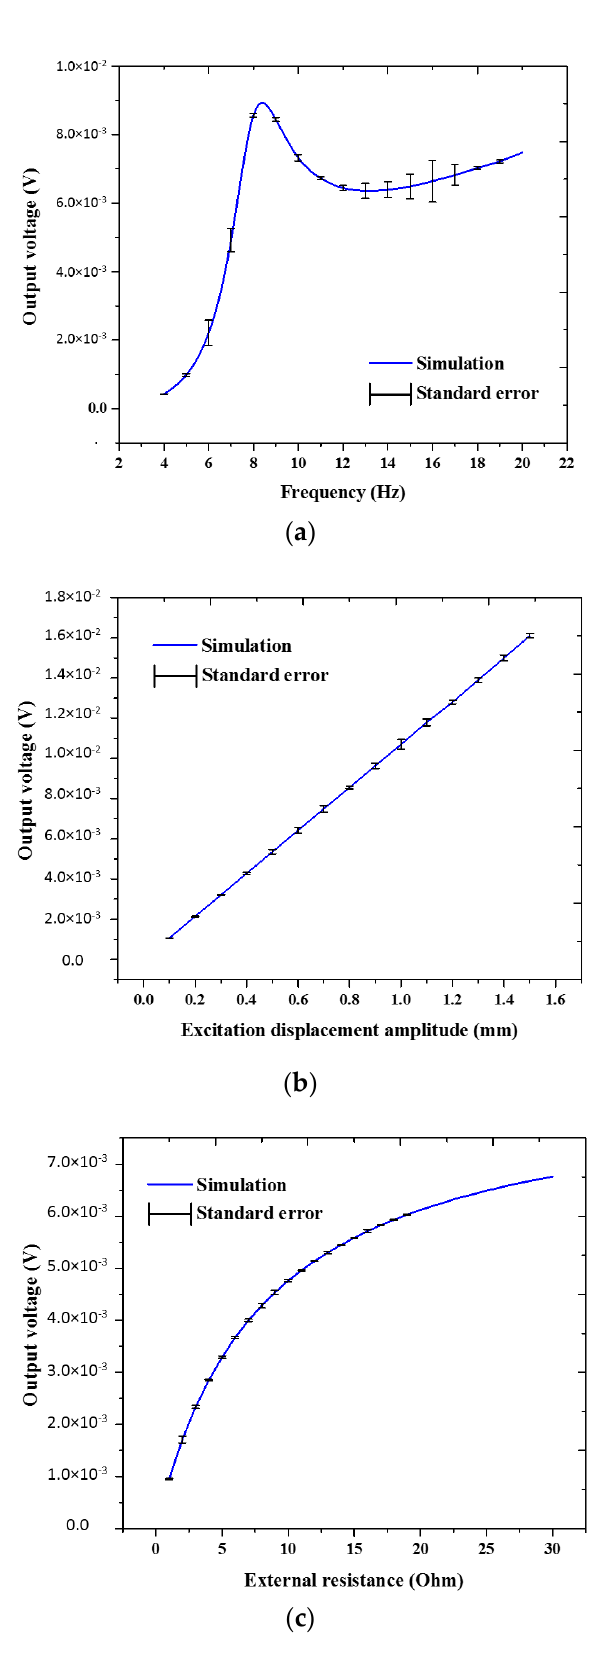
Figure 6. Simulated (the blue curve) output voltage of the device and experimental results with error bars by changing the excitation frequency ( a ), the excitation amplitude ( b ), and the external resistance ( c ).